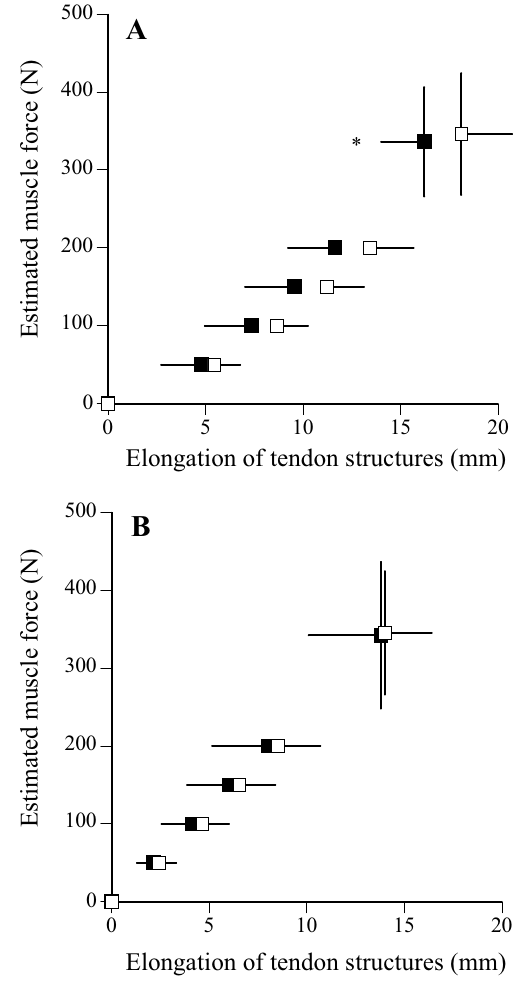
Figure 3. Relationship between estimated muscle force and elongation of tendon structures during ramp ( A ) and ballistic ( B ) contractions in middle-aged (closed) and young (open) men. Data are mean ± SD. Significant difference from young men: *p < 0.05.